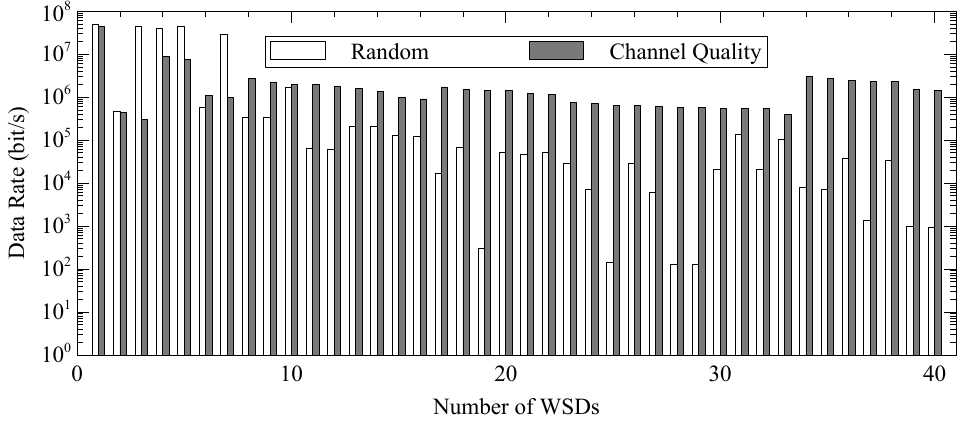
Figure 2. Average Data Rate for WSDs with and without the Proposed Channel Selection Approach.